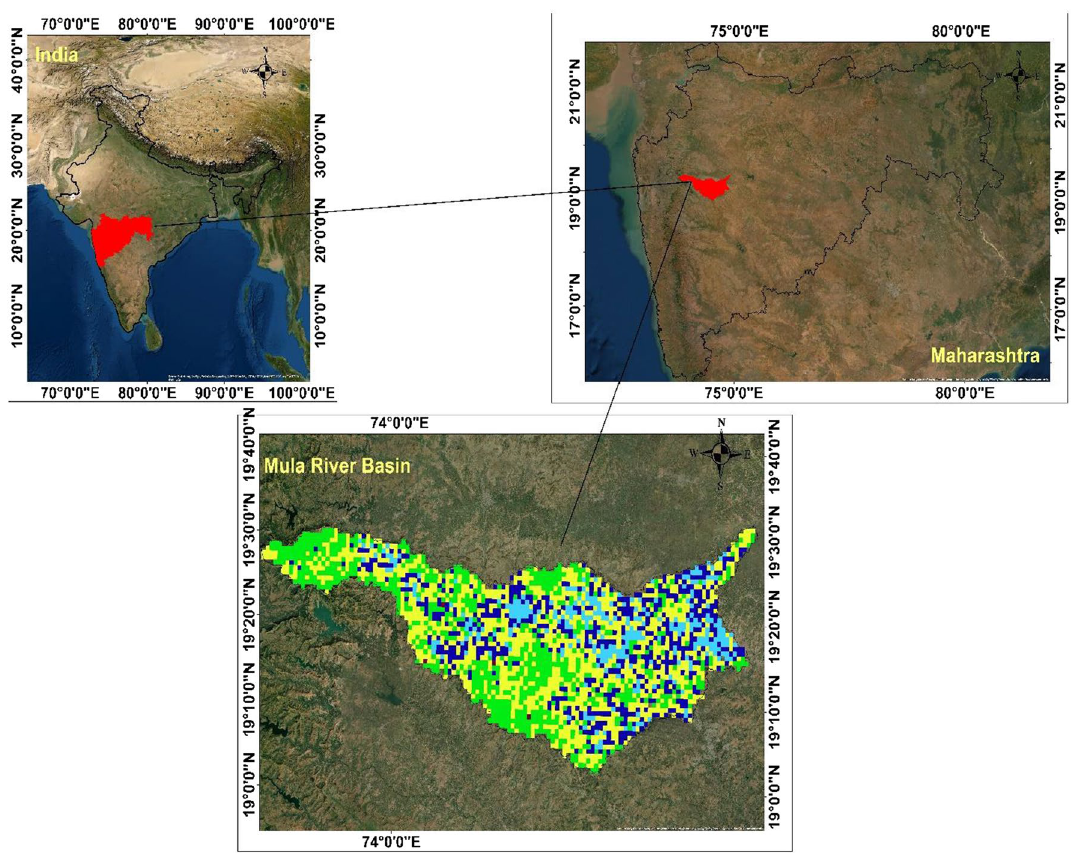
Fig. 1 Location map of Mula river basin